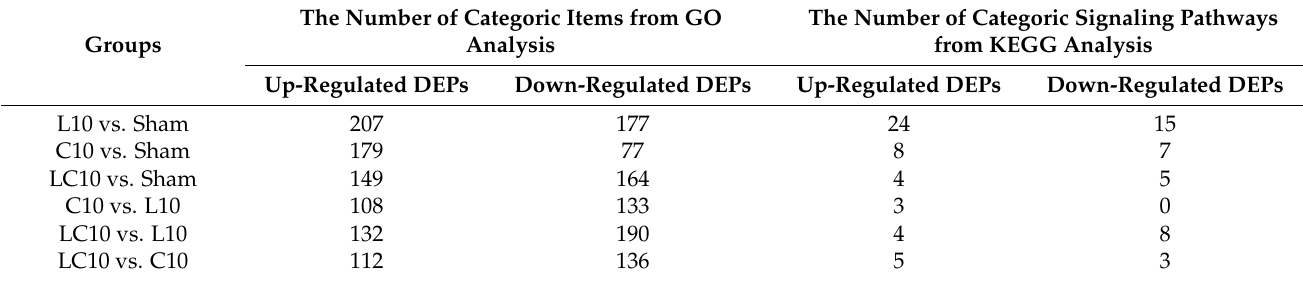
Table 6. The gene set enrichment analysis of DEPs after compound microwave exposure in the